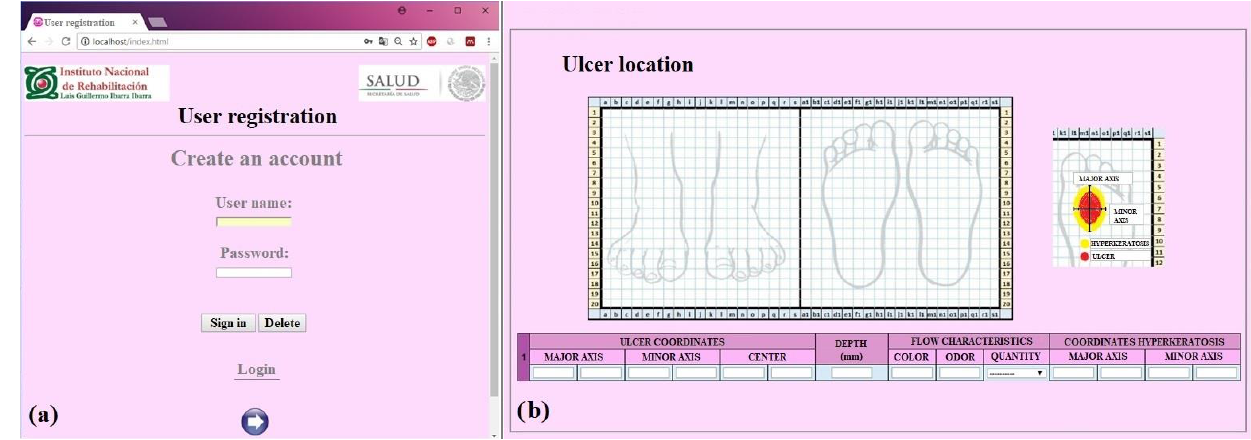
Figure 11. ( a ) Screen of the virtual platform to create a new account and log in; ( b ) screen for locating patients ’ ulcers by recording their coordinates and their characteristics.